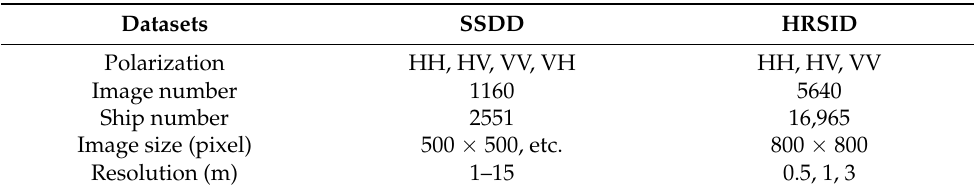
Table 1. Details of two datasets.